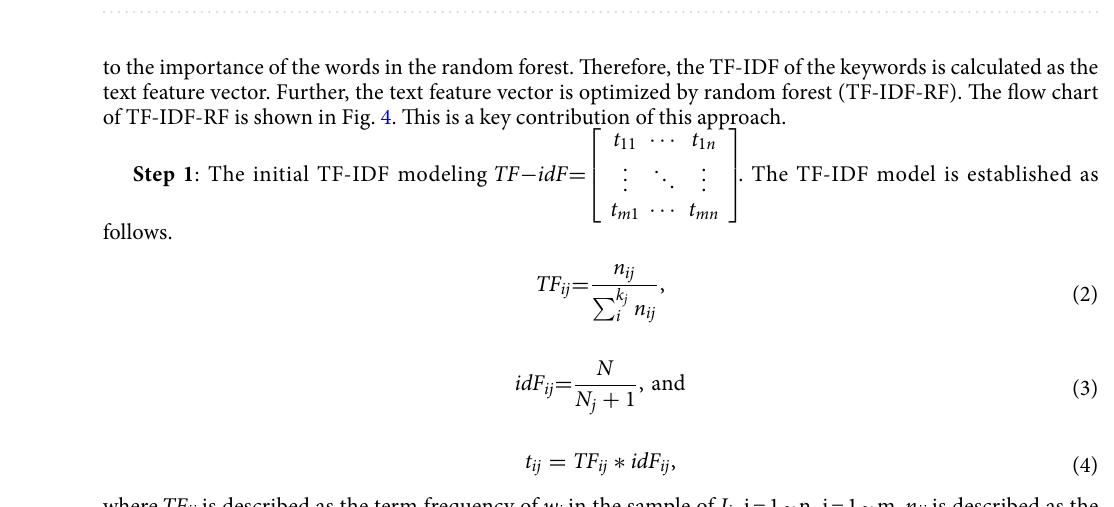
Figure 4. Proposed approach of